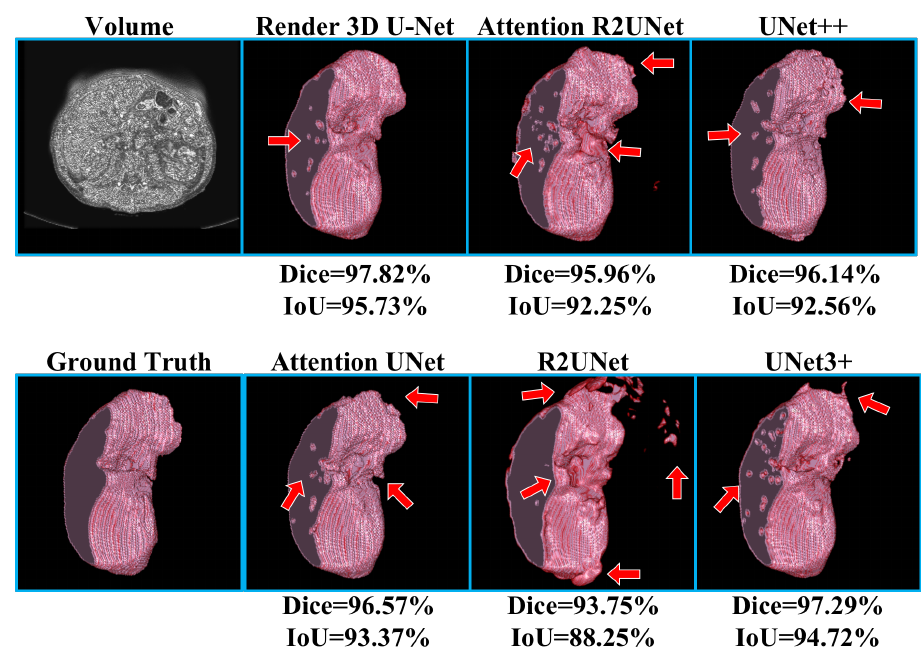
Figure 8. Comparison of model outputs and ground truth, where the prediction-missed areas are highlighted with red arrows: the prediction of Render 3D U-Net is generated under the point-sampling method and false positive classification module.